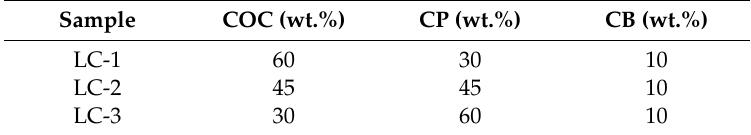
Table 1. Compositions of thermochromic liquid crystal (LC) formulations which are ternary mixtures of cholesteryl benzoate (CB), cholesteryl pelargonate (CP), and cholesteryl oleyl carbonate